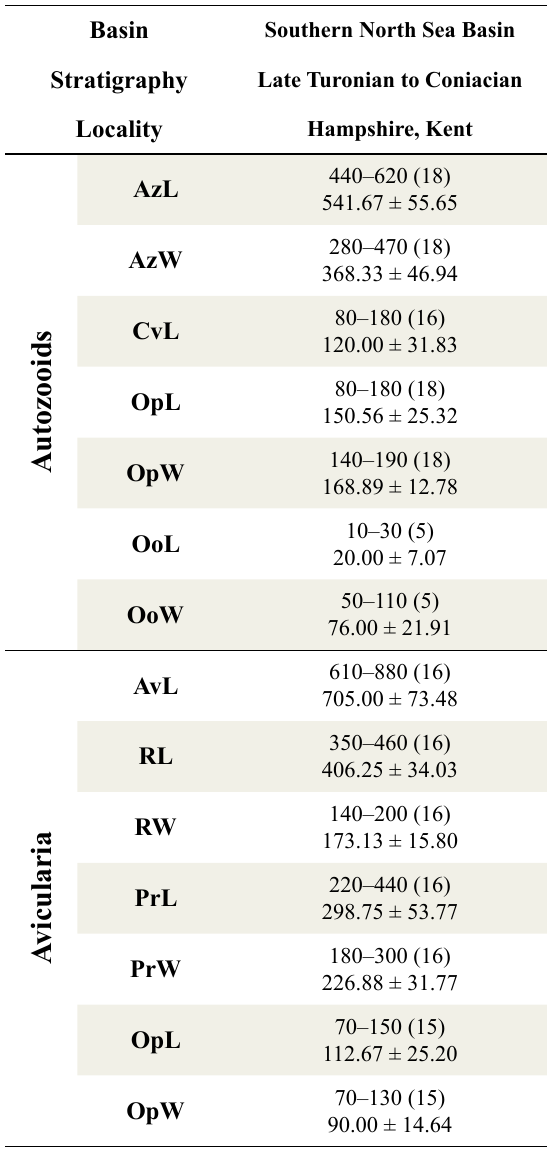
Table 2. Summary of measurements of Rhagasostoma brydonei sp. nov. For each parameter the range is given with the number of measurements in brackets. The arithmetic mean is given ± standard deviation. All measurements in